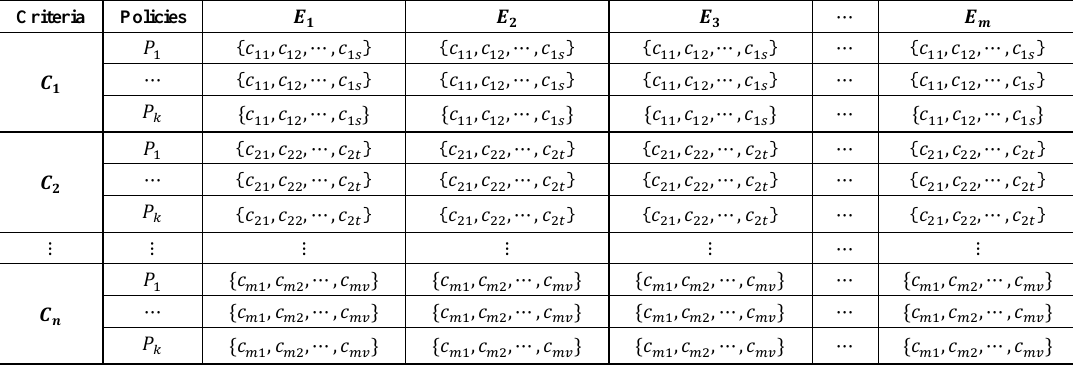
Table 1. List of the policies for